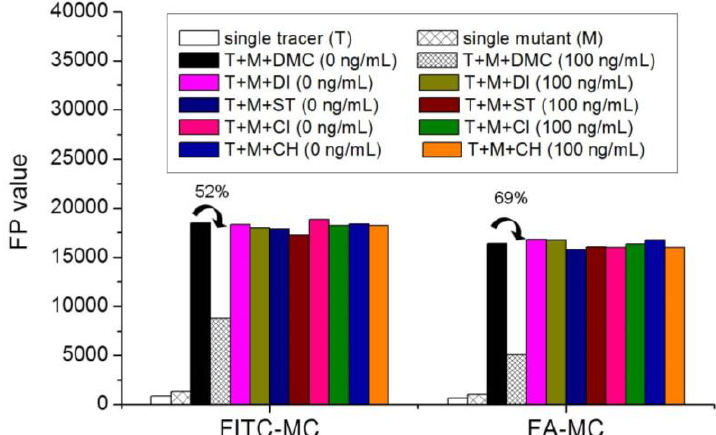
Figure 4. FP values when testing DMC and other drugs by using the two fluorescent tracers (DI=diazepam, ST=streptomycin, CI=ciprofloxacin, CH=chlorpromazine; n =5).